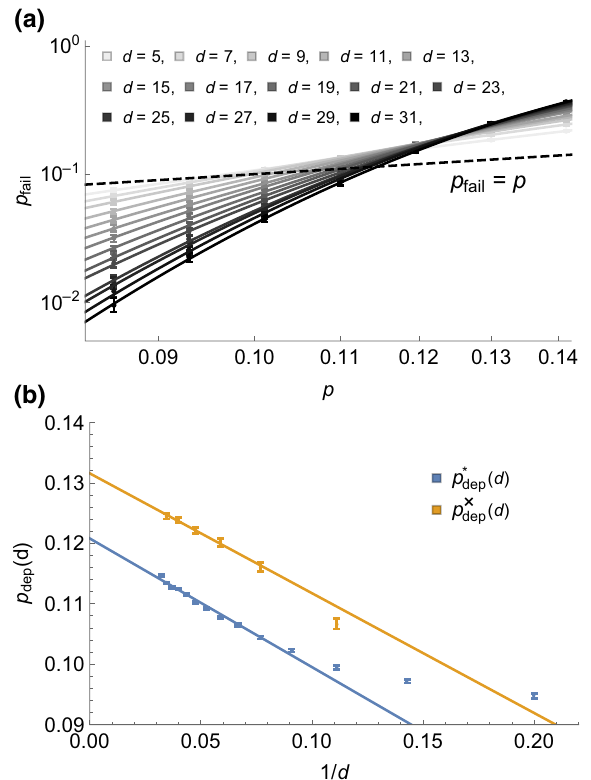
FIG. 10. (a) Performance of the projection decoder for the 2D color code of distance d under depolarizing noise and perfect ( d ) and the cross- measurements. (b) The pseudothresholds p ∗ dep ( d ) between pairs of curves corresponding to distances ings p × dep d and ( d + 1 )/ 2 for various d . From a linear extrapolation of the ( d ) and data for d ≥ 11 we obtain intercepts of 13.16(4)% for p × dep ( d ) . 12.08(4)% for p ∗ dep